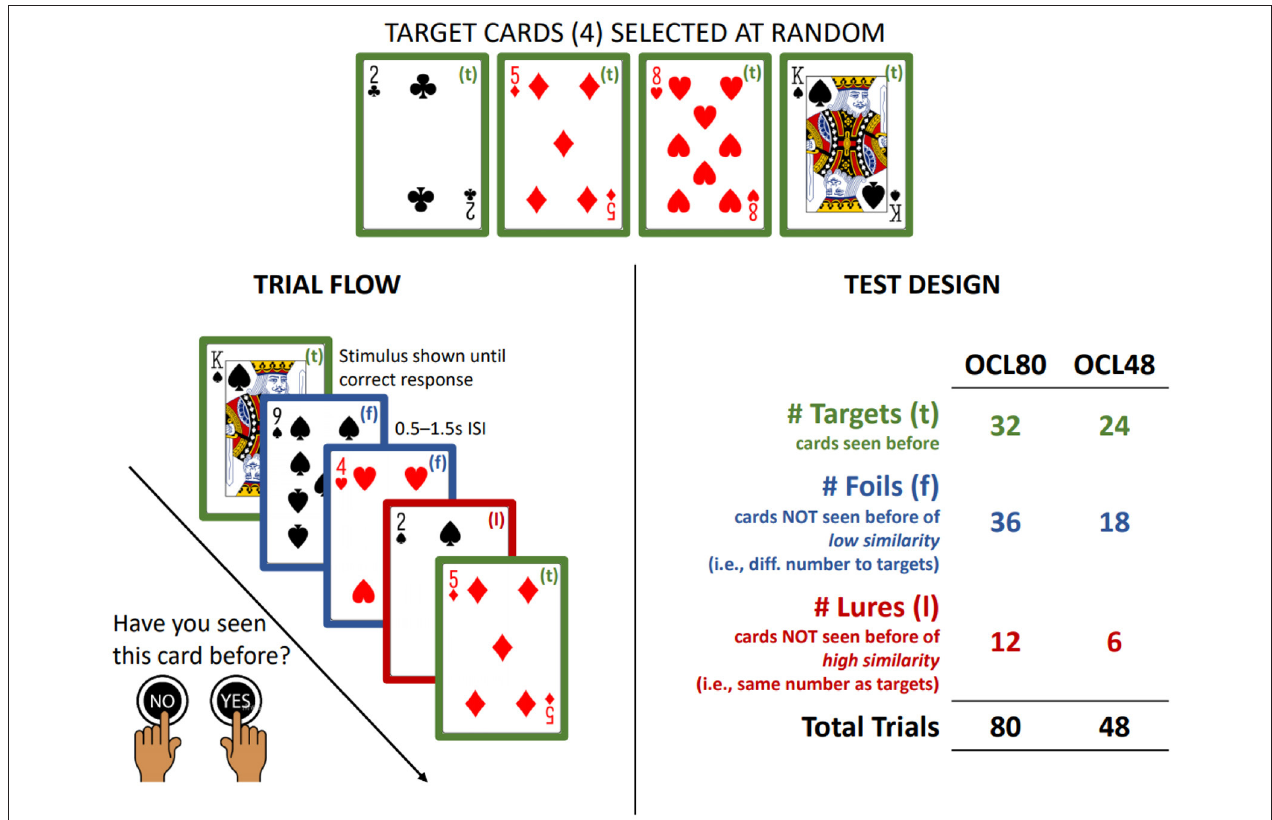
FIGURE 1 | Summary of OCL48 and OCL80. Summary of the trial flow and design of the OCL48 and OCL80. ISI, Inter-Stimulus